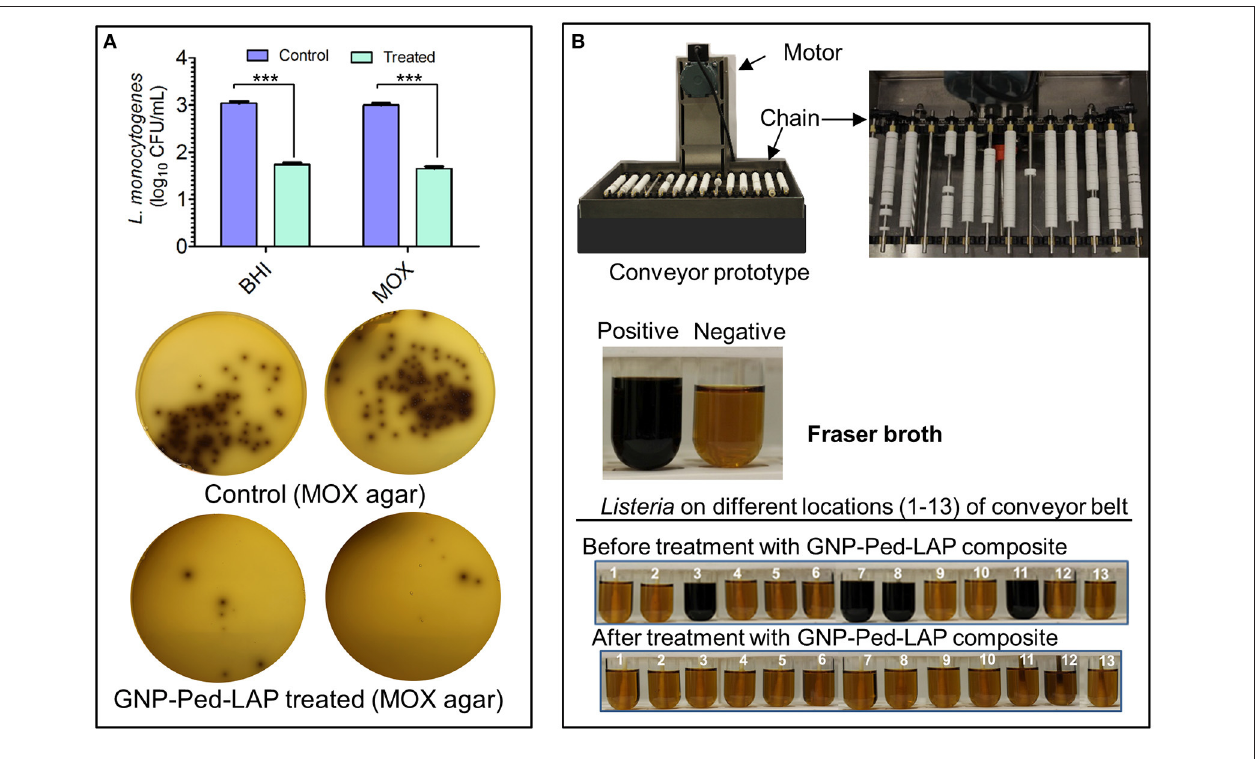
FIGURE 6 | Application of gold nanoconjugates as a surface decontaminant to inhibit L. monocytogenes . (A) The antilisterial activity of GNP-Pediocin-LAP nanoconjugates on the agar surface. Agar plates were first pre-seeded with bacteria and then treated with gold nanoconjugates. (B) Prototype conveyer belt system was used to assess the antilisterial activity of GNP-Pediocin-LAP nanoconjugates at various locations of the conveyor (see also Table 2 ). Fraser broth containing esculin and ferric ammonium citrate was used to observe the Listeria growth turning pale yellow media to black due to esculin hydrolase activity. Data are average of three independent experiments analyzed in triplicate. *** P < 0.0001. BHI, brain heart infusion; MOX, modified Oxford agar.